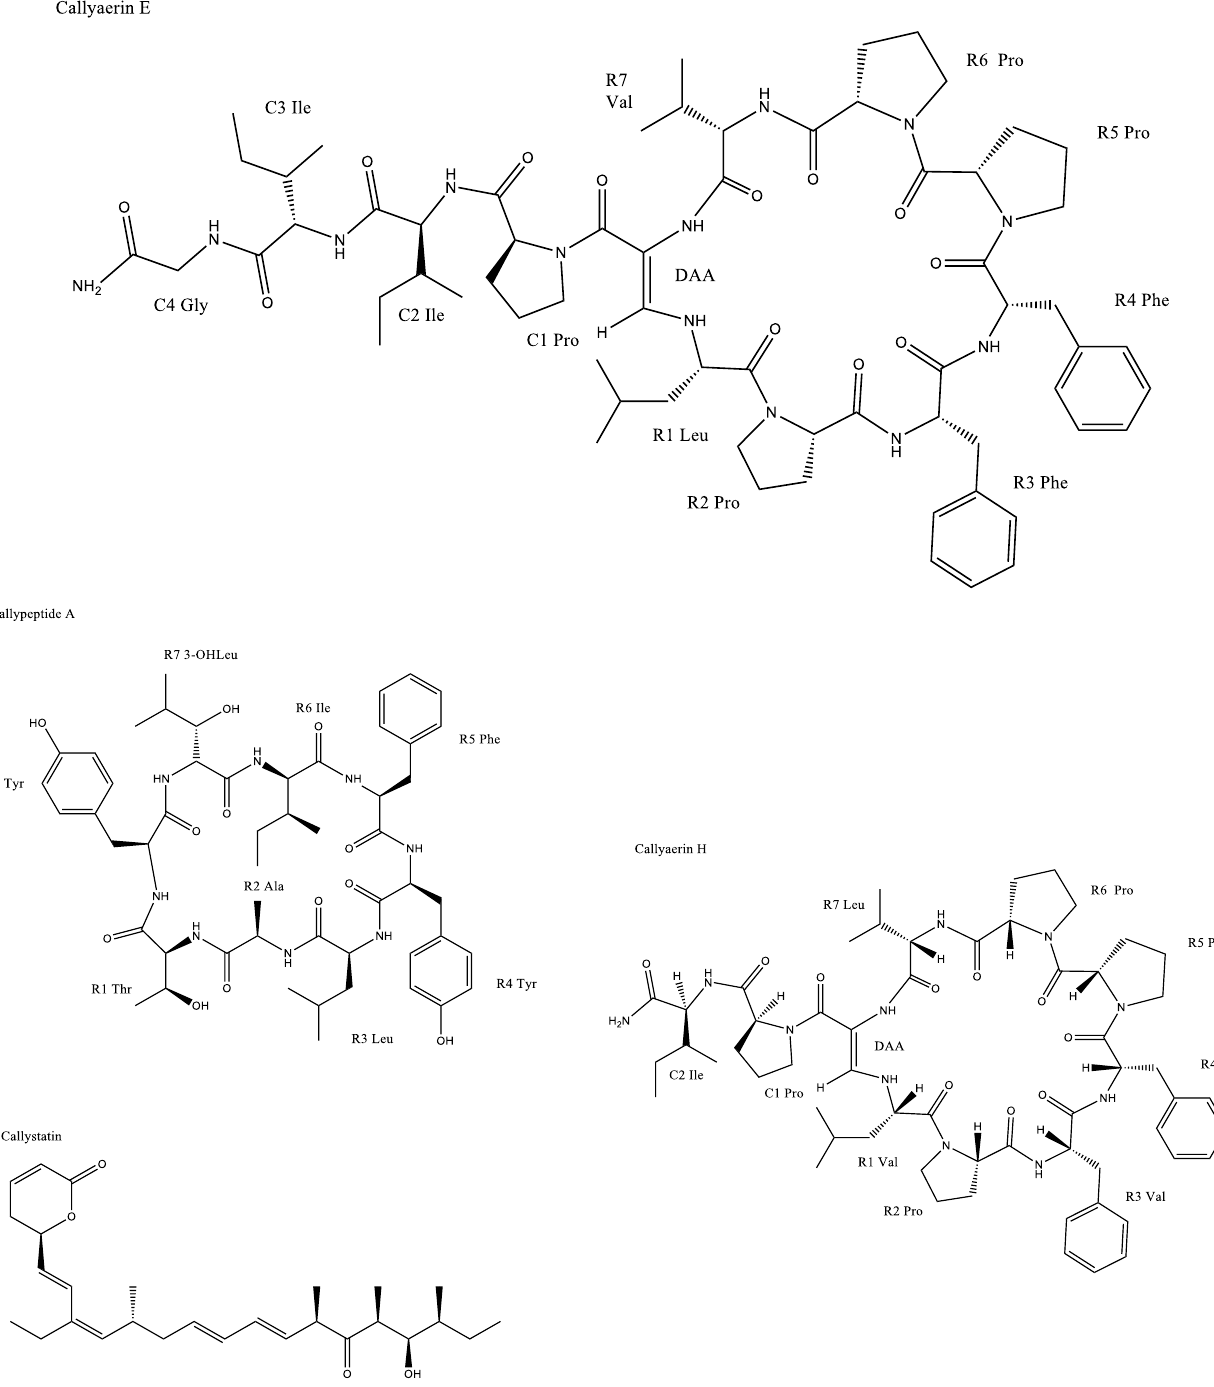
Figure 3. Structure of secondary metabolites from the Callyspongia subgenus.